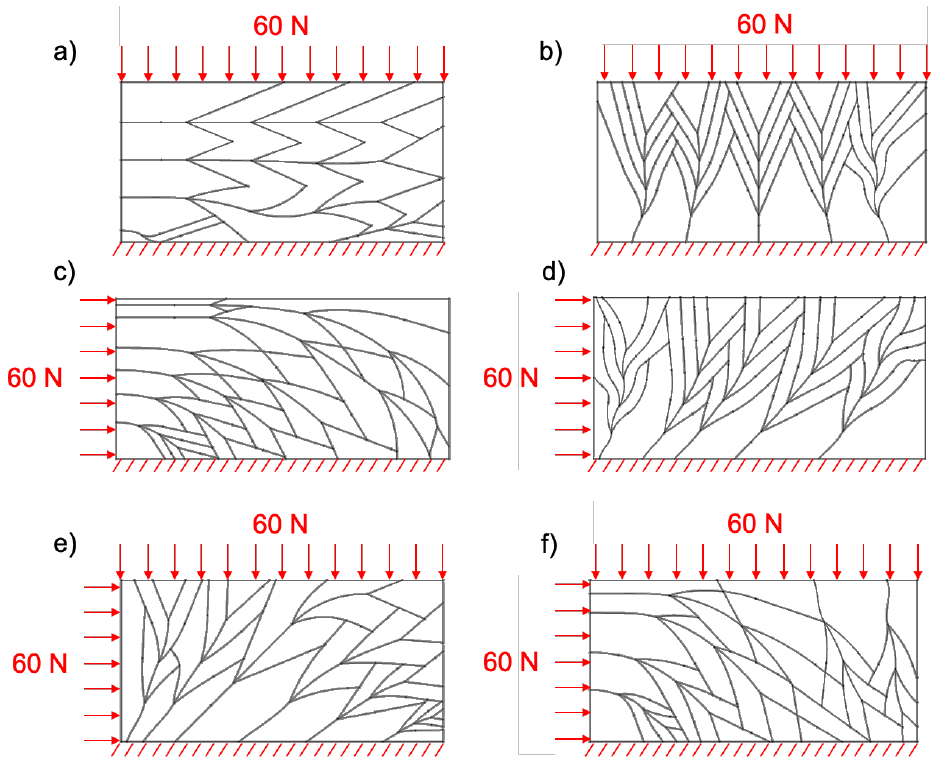
Figure 6. L-system models studied in this paper: ( a ) CL-1, ( b ) CL-2, ( c ) SL-1, ( d ) SL-2, ( e ) CSL-1, and ( f ) CSL-2.